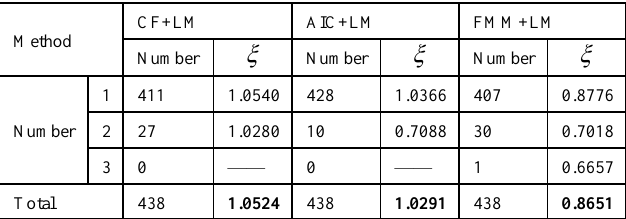
Table 1. The performance evaluation of waveform